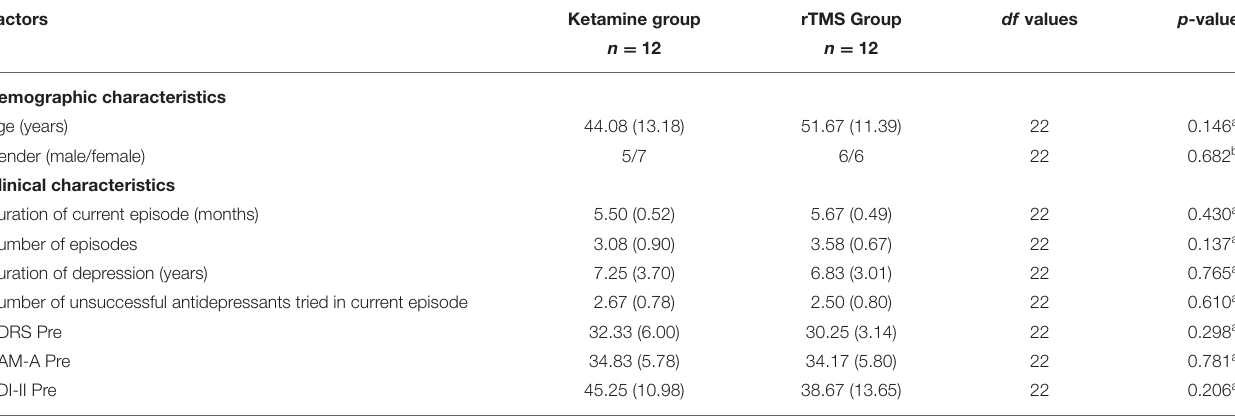
TABLE 1 | Baseline characteristics of ( N = 24) participants.